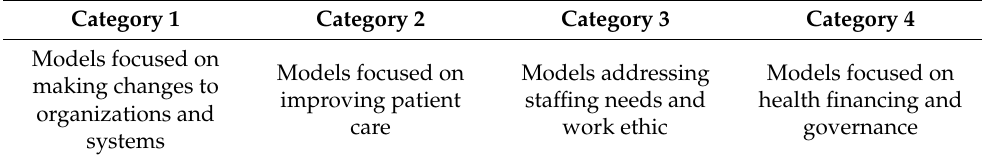
Table 1. Categories of models for integrated health care in developed countries